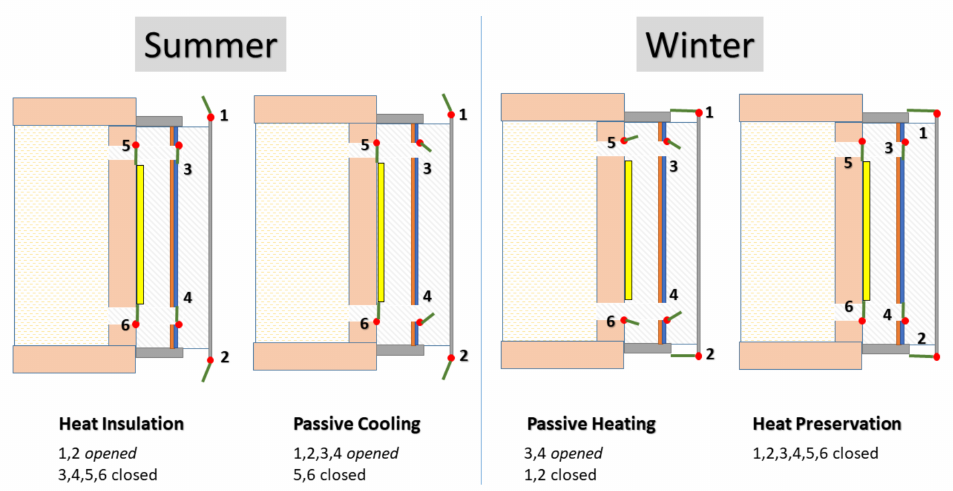
Figure 4. Modified Trombe wall mechanism studied by Luo et al.